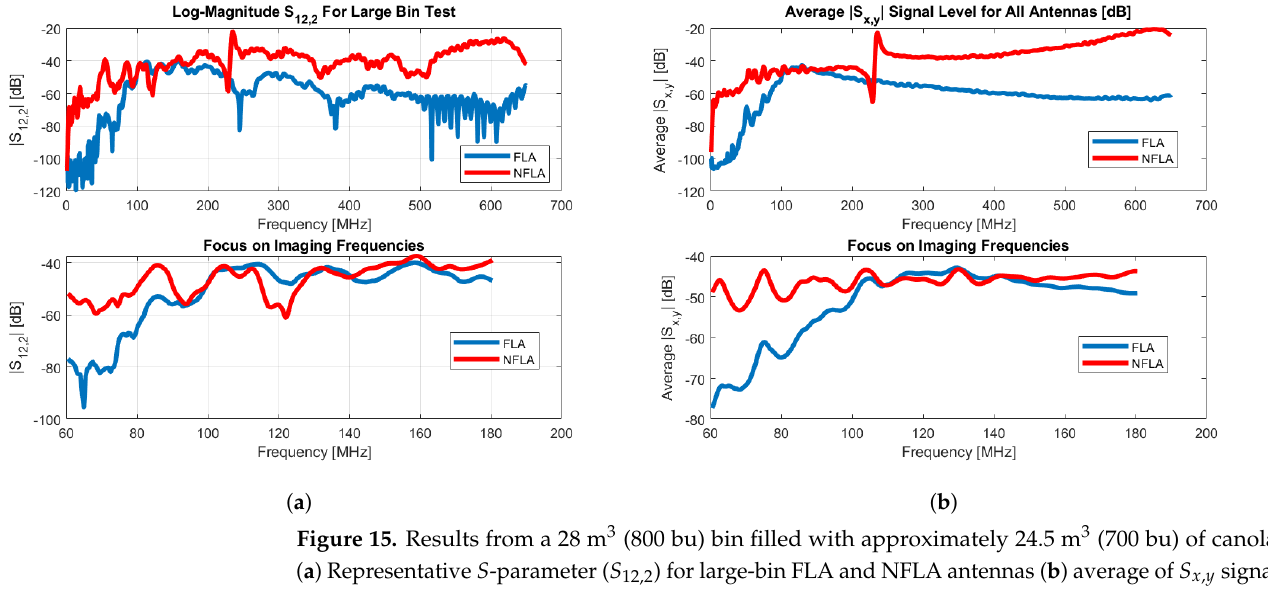
Figure 15. Results from a 28 m 3 (800 bu) bin filled with approximately 24.5 m 3 (700 bu) of canola. ( a ) Representative S -parameter ( S 12,2 ) for large-bin FLA and NFLA antennas ( b ) average of S x , y signal strength overall all possible antenna pairs. Note that the NFLA antennas have 12.55 times the loop area as the FLA antennas, thus absent any ferrite we would expect 22 dB more signal from the NFLAs over the